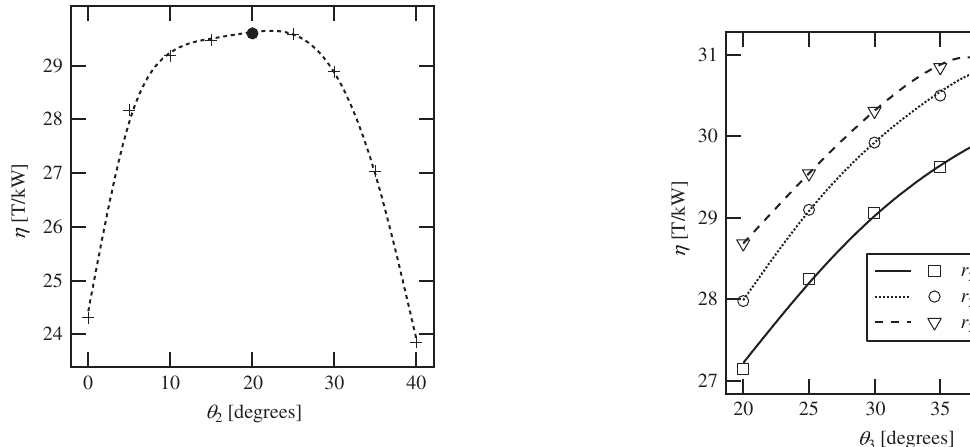
FIG. 5. Magnetic efficiency η as defined in Eq. (10), vs taper angle θ 2 , at r 0 ¼ 12 . 5 mm, r 2 ¼ 80 mm and for a 545 mm total length (including coil heads). The black dot indicates the design value and the lines are spline interpolations between the simu- lated points